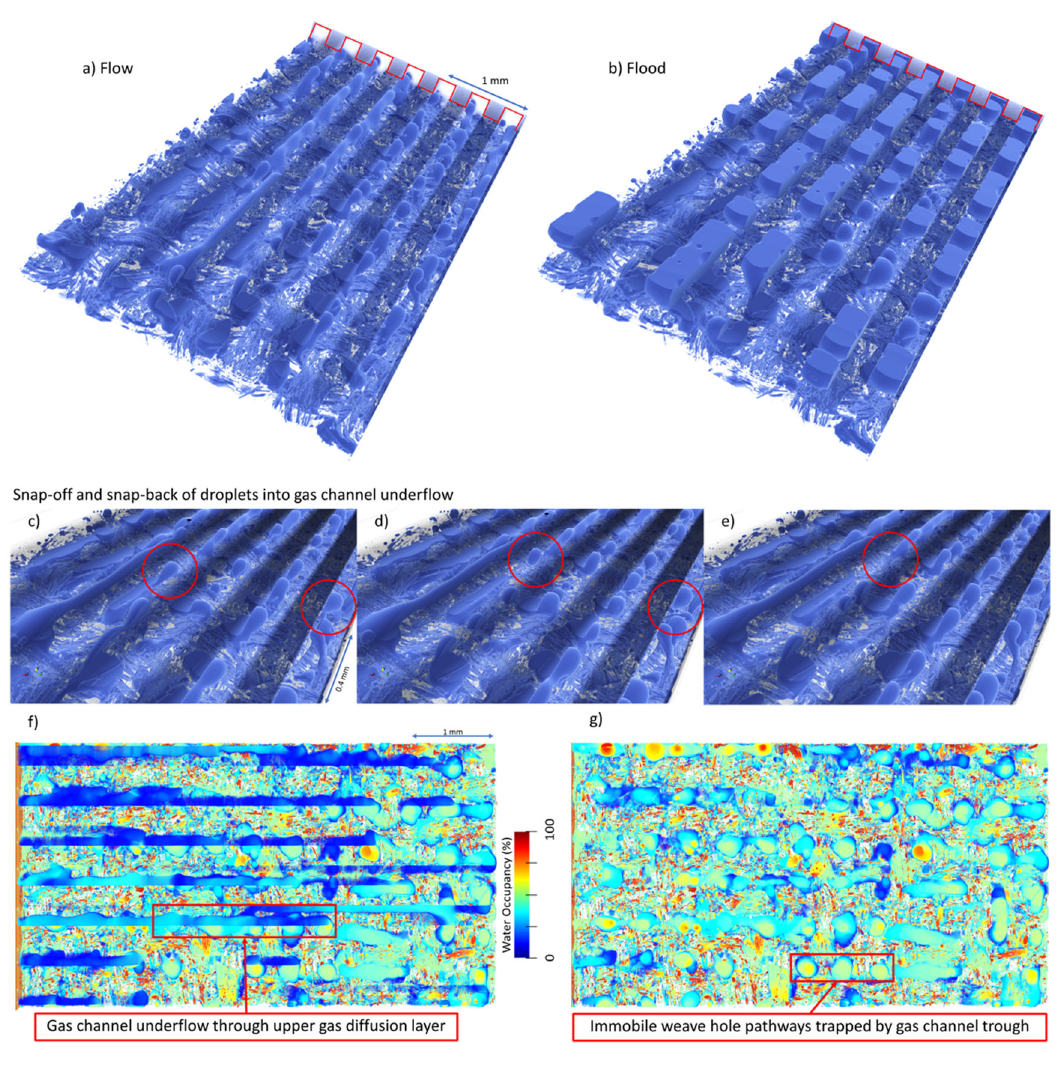
Fig. 5 | Water-air fl ow simulations in the PEMFC. Flow patterns for simulated a fl ow, and b fl ood regimes. c – e Flow patterns showing droplets snapping out of and back into GDL weave holes in gas channel under fl ow. f – g Water occupancy